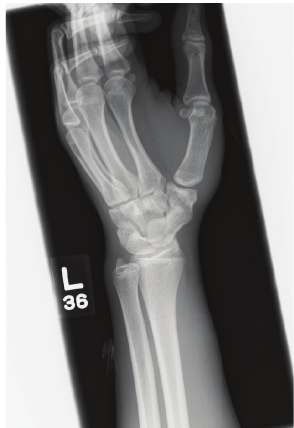
Figure 1: Oblique radiograph of the left wrist in patient 1 demon- strates osseous carpal coalition of the scaphoid and trapezium.